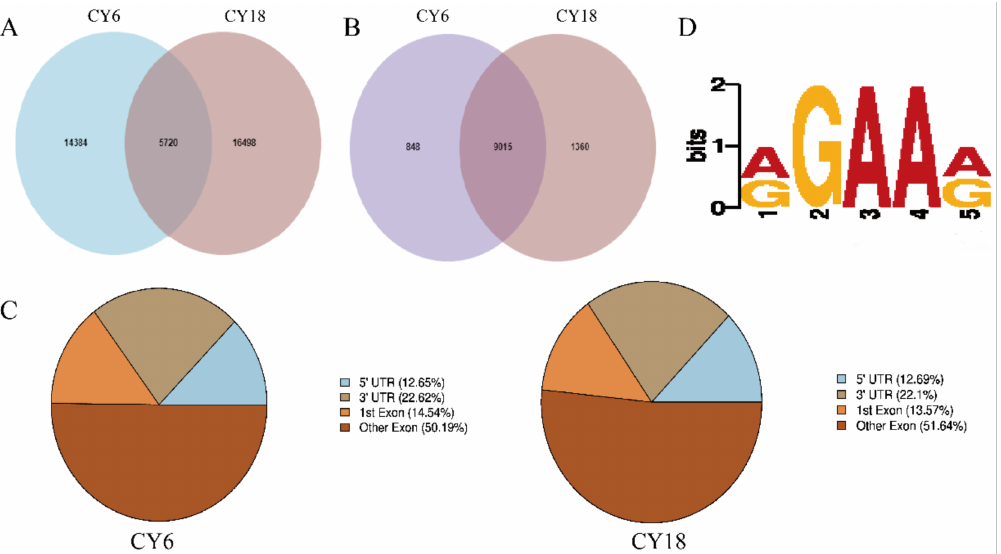
Figure 2. Transcriptome-wide m 6 A-seq and m 6 A peak analysis: ( A ) the common and specific m 6 A peaks in two groups; ( B ) the m 6 A peaks for genes in two groups of Venn diagrams; ( C ) pie chart for the peak in gene functional element region annotation; ( D ) sequence logo representing the consensus motif identified by